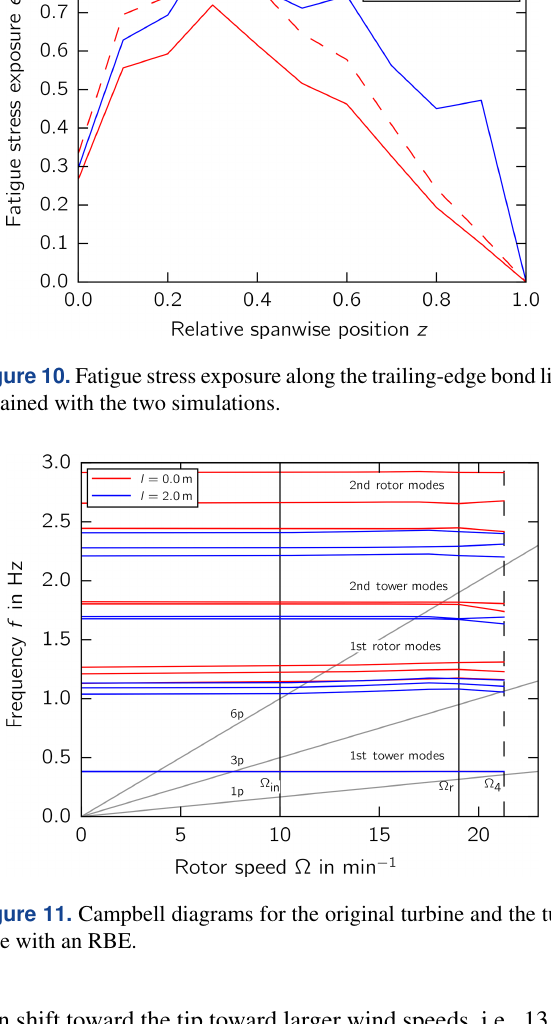
covered by the blue bar in the static simulation, which in- cludes the load factor of γ l = 1 . 25.